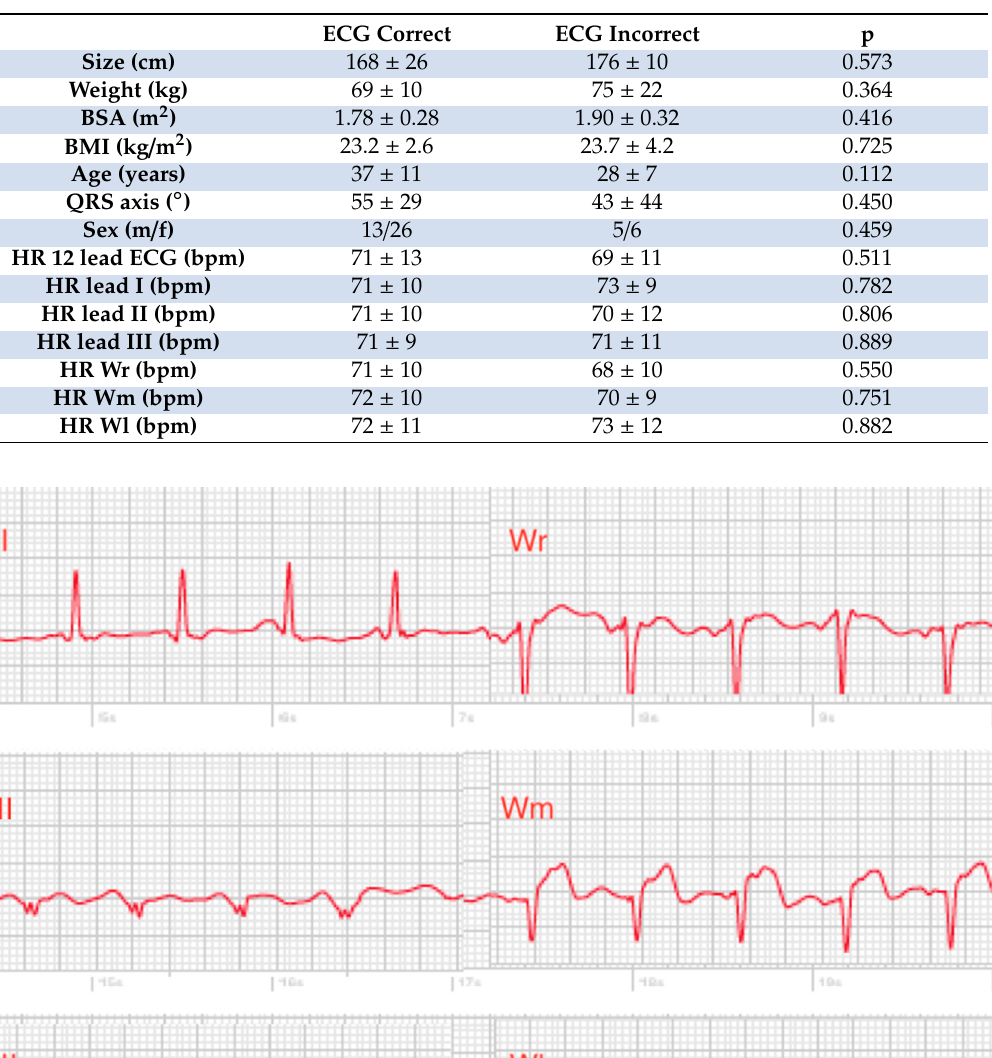
Correlations between correct ECG assumption and study population characteristics (BSA = body surface area, BMI = body mass index, HR = heart rate, lead I = Einthoven lead I, lead II = Einthoven lead II, lead III = Einthoven lead III, Wr = pseudo-unipolar recording corresponding to standard lead V1, Wm = pseudo-unipolar recording corresponding to standard lead V4, Wl = pseudo-unipolar recording corresponding to standard lead V6). P values were obtained by T-Test, ANOVA and χ 2-test; probability limit 95%.